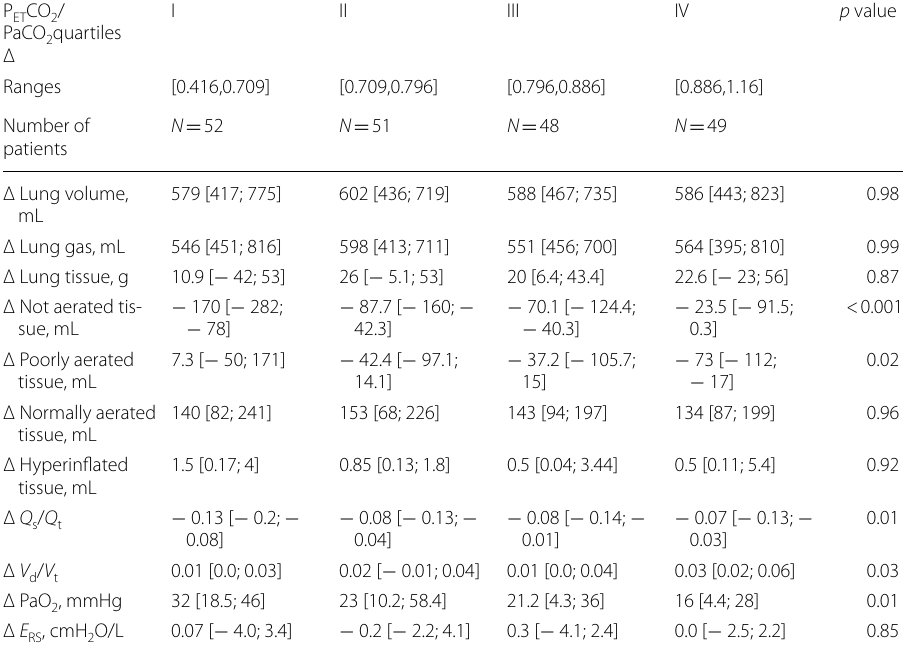
Differences were computed as the variable at PEEP 15 cmH 2 O minus the variable at PEEP 5 cmH 2 O. Variables are expressed in medians and IQR. P for Mann–Whitney test. Q s / Q t : shunt fraction; V d / V t : dead space fraction; P / F : PaO 2 /FiO 2 ratio; E RS